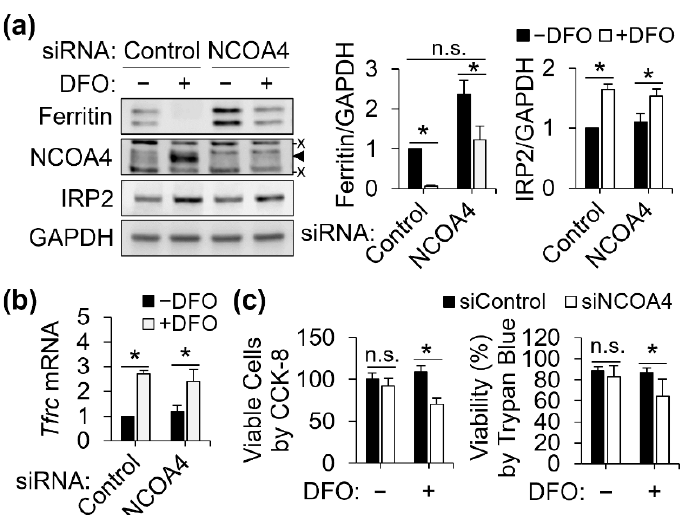
Figure 2. NCOA4 is required for the adaptation to cellular iron deprivation by J774 cells . J774 macrophages were treated with DFO (100 μM) for 18 h after 24 h of NCOA4 siRNA transfection. ( a ) Effects of NCOA4 and iron deficiency on ferritin and IRP2 protein abundance ( n = 3 independent experiments). ( b ) Response of Tfrc mRNA abundance to iron restriction is not affected by NCOA4 depletion ( n = 3 independent experiments). ( c ) Decrease in viable cell number by co-depletion of iron and NCOA4 by DFO and RNAi, respectively. Relative numbers of viable cells were determined using Cell Counting Kit 8 (CCK-8) and are shown in percentage of the average measure of cells with control siRNA without DFO treatment. Cell viability was determined by trypan blue exclusion ( n = 4–5 biological replicates). All data presented as mean ± SD. *, p < 0.05. n.s., not significant. x, non-specific band. ◄ , NCOA4 band.